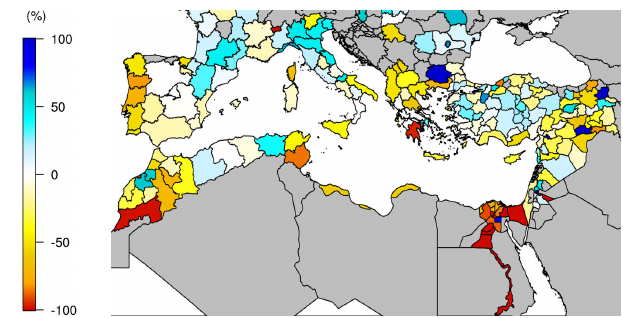
Figure 2. LPJmL-simulated net irrigation water requirements (NIR), as average over the period 2000–2009.